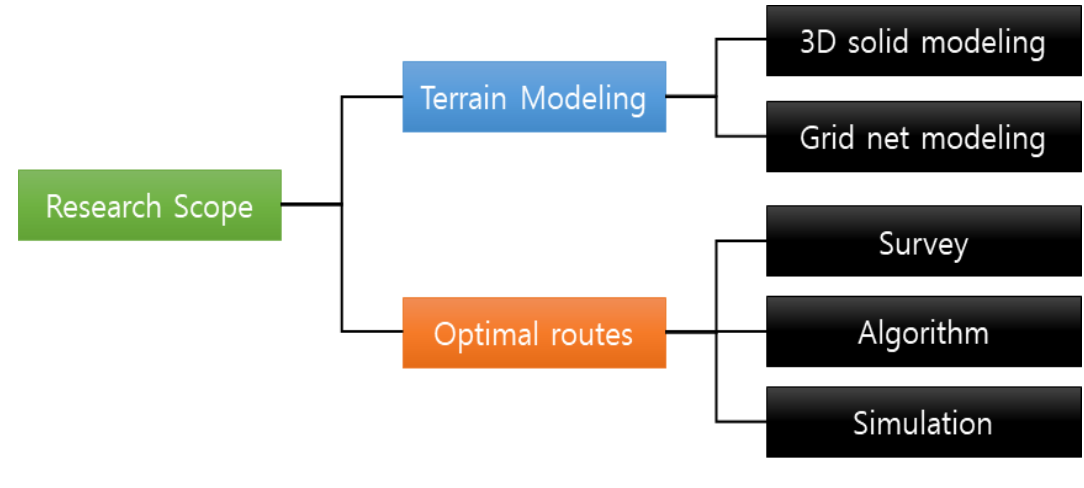
Figure 1. Research Scope.